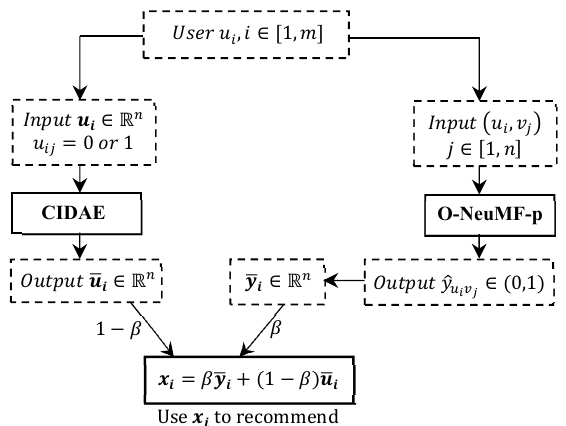
Figure 3. The structure of I-NMF.